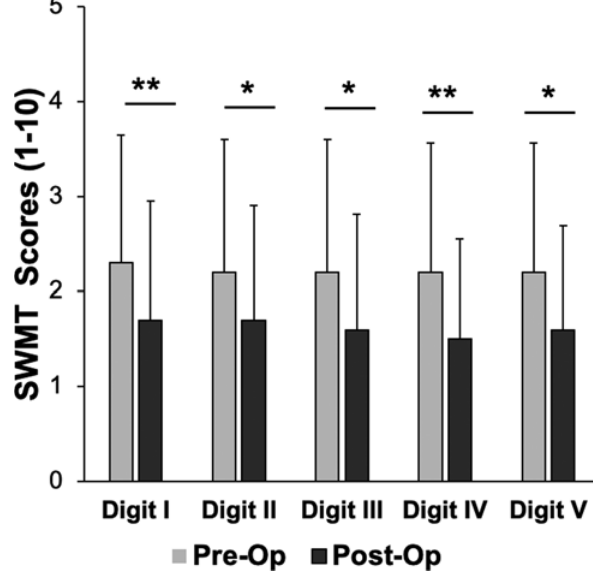
Fig. 8 Semmes-Weinstein mono fi lament test (SWMT) for tactile sensation within the fi nger pulps of the affected extremity, before and after surgery. Data shown as mean (cid:1) SD. ( n ¼ 21 patients). (cid:4) p < 0.05, (cid:4)(cid:4) p < 0.01. SD, standard